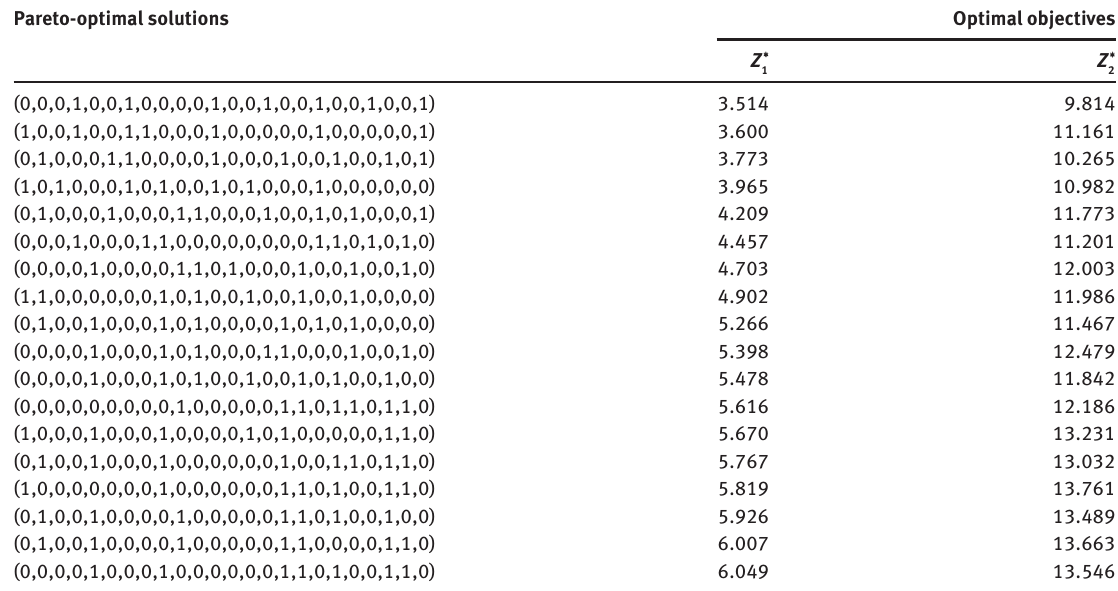
Table 3: Pareto-Optimal Solutions of Illustrative Case. Pareto-optimal